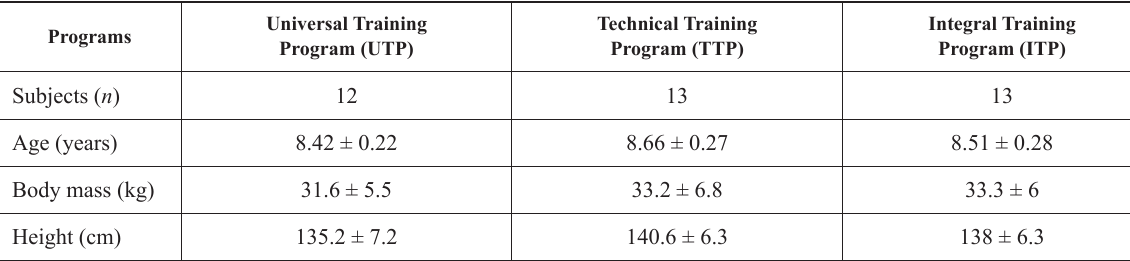
Table 1. Subjects of different training programs (mean ± SD )